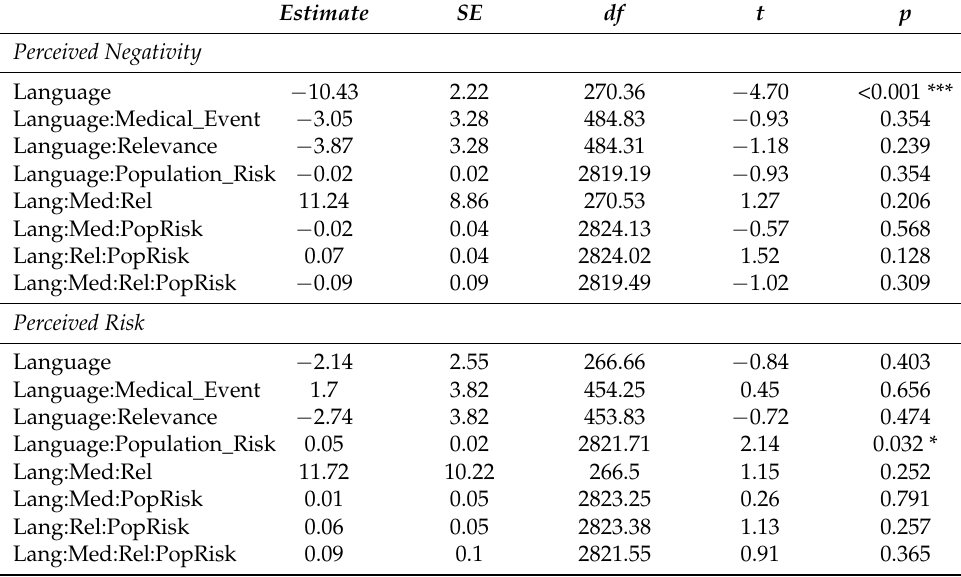
Table 2. Effects of Language on Perceived Negativity and Perceived